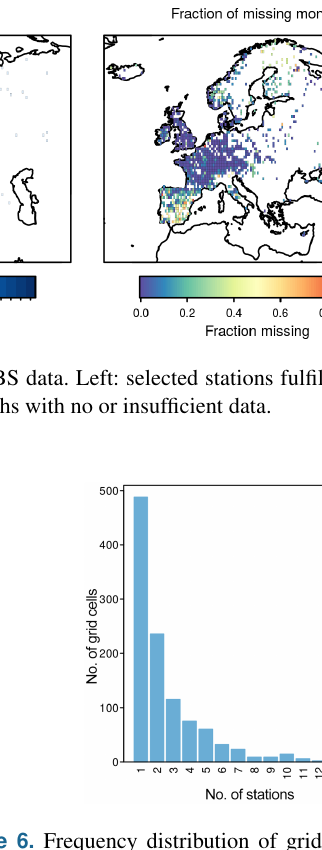
Figure 6. Frequency distribution of grid cells with 1, 2, ..., 24 stations. Table 3. Number of grid cells for which 0, 1, ..., 4 of the con- sidered tests reject the null hypothesis of no breakpoint (1% level) at monthly resolution. Grid cells with more than one rejection are excluded from the